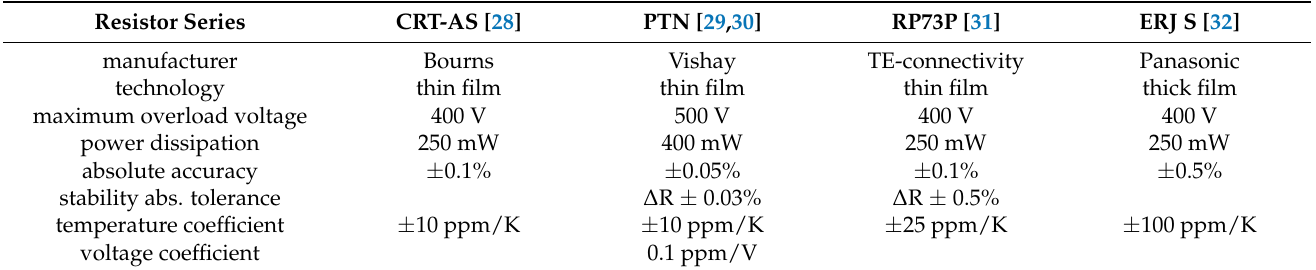
Table 2. Comparison of selected values of various resistors in package 1206 with a nominal value of 1 M Ω